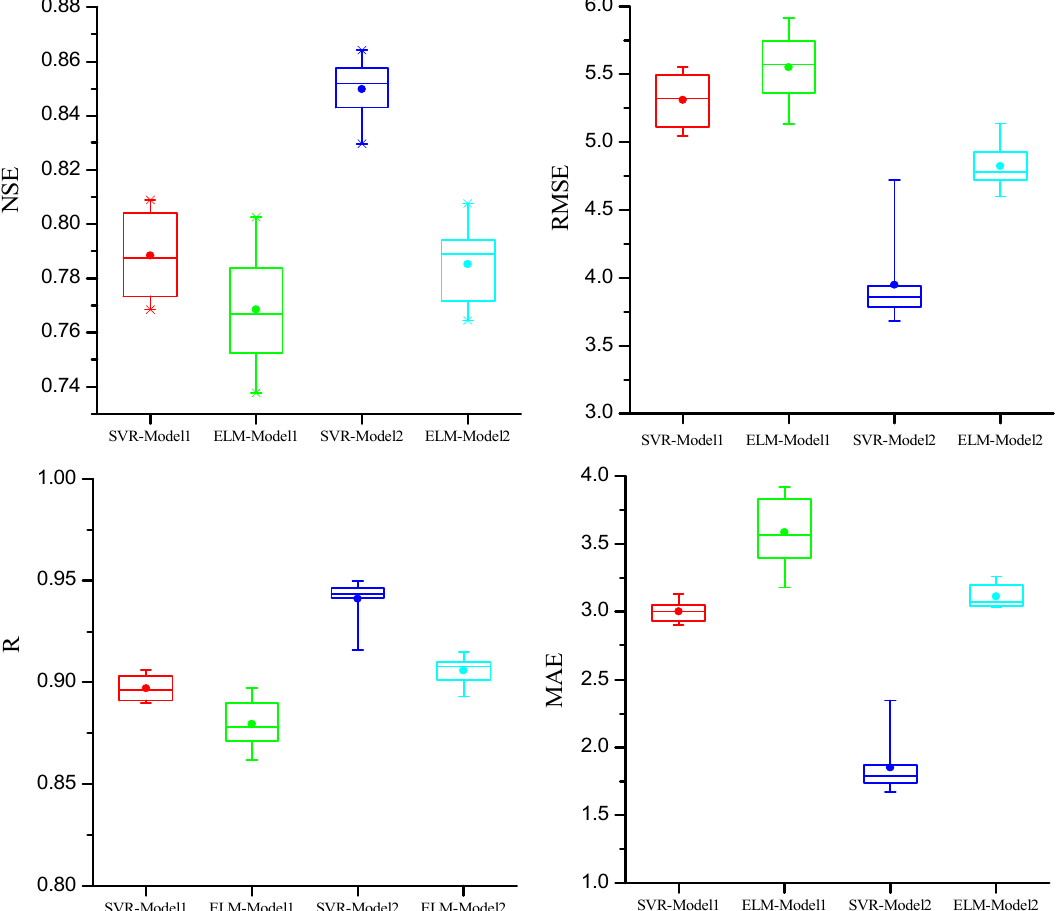
Figure 7. Box plots of historical streamflow hindcast performances of SVR and ELM derived from the selected eight GCMs. The dot represents the average value, the upper and lower hinges represent the 75th and 25th percentiles, respectively. The whiskers show the other data points, except for the outliers. The line within the box shows the median.